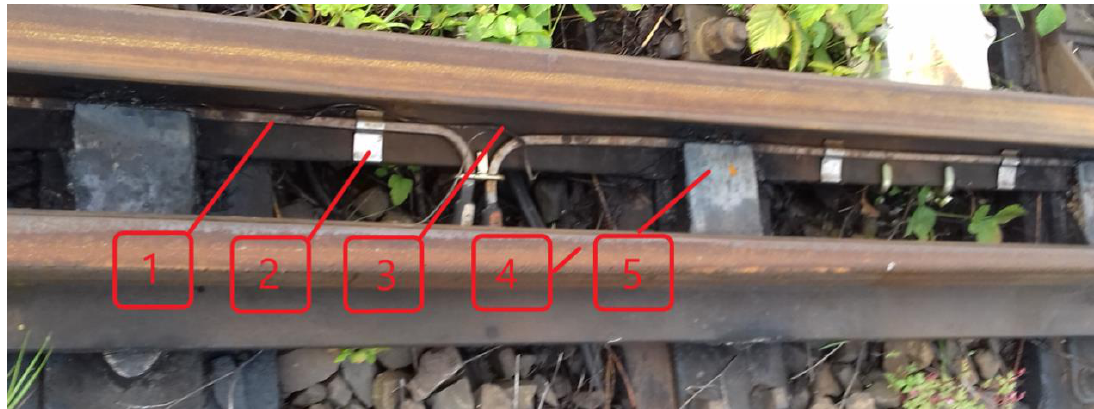
Figure 2. Built-in flat-oval resistance heaters (1) mounted with special holders (2) to the foot of the stock rail (3); (4)—switch rail, (5)—plates.